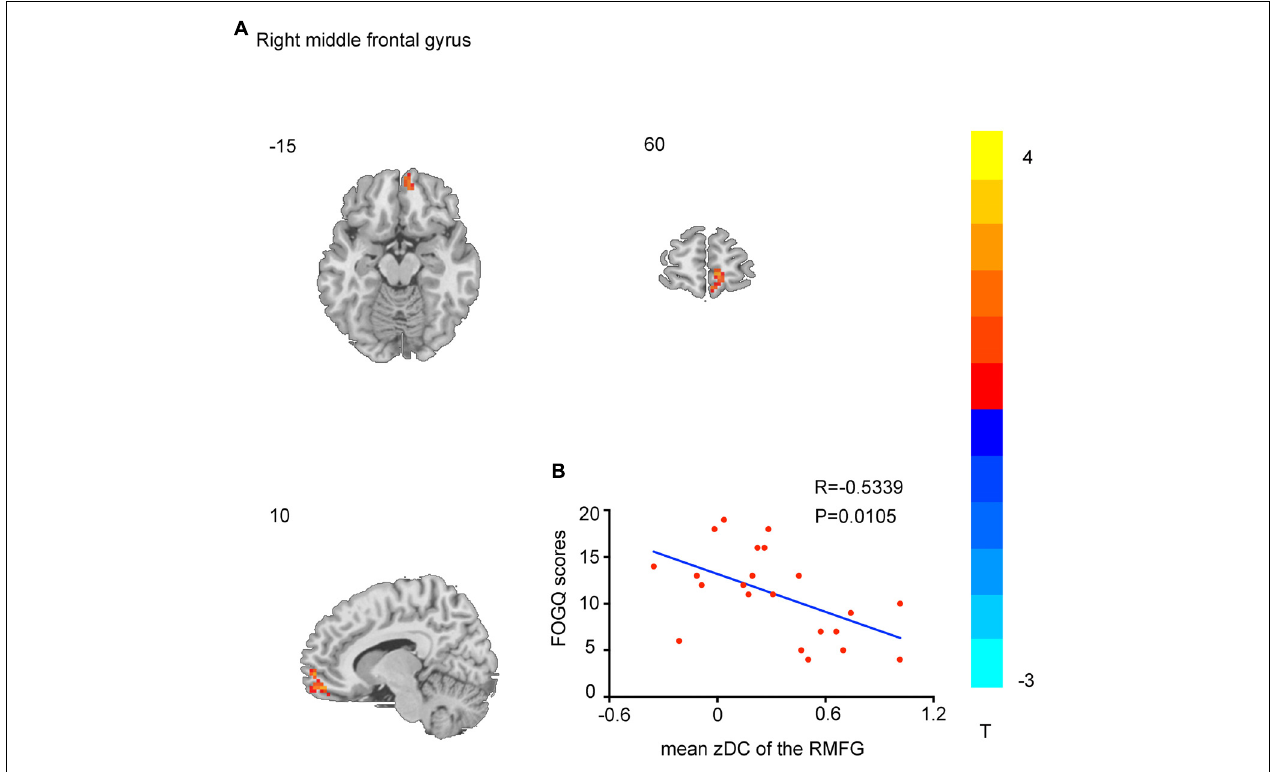
FIGURE 2 | Brain regions showing DC differences between Parkinson’s disease with freezing of gait (PD-FOG) and PD patients without FOG (PD-nFOG) groups. Only right middle frontal gyrus (RMFG) had decreased DC ( p < 0.001, AlphaSim-corrected). The t -value scale is seen to the right of the image (A) . The scatter plot shows the negative correlation between RMFG DC values and Freezing of Gait Questionnaire (FOGQ) scores in PD-FOG patients (B)